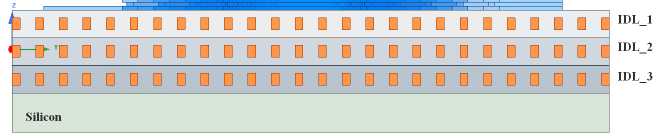
Figure 11. Side view of an inductor containing three layers of DMFs.